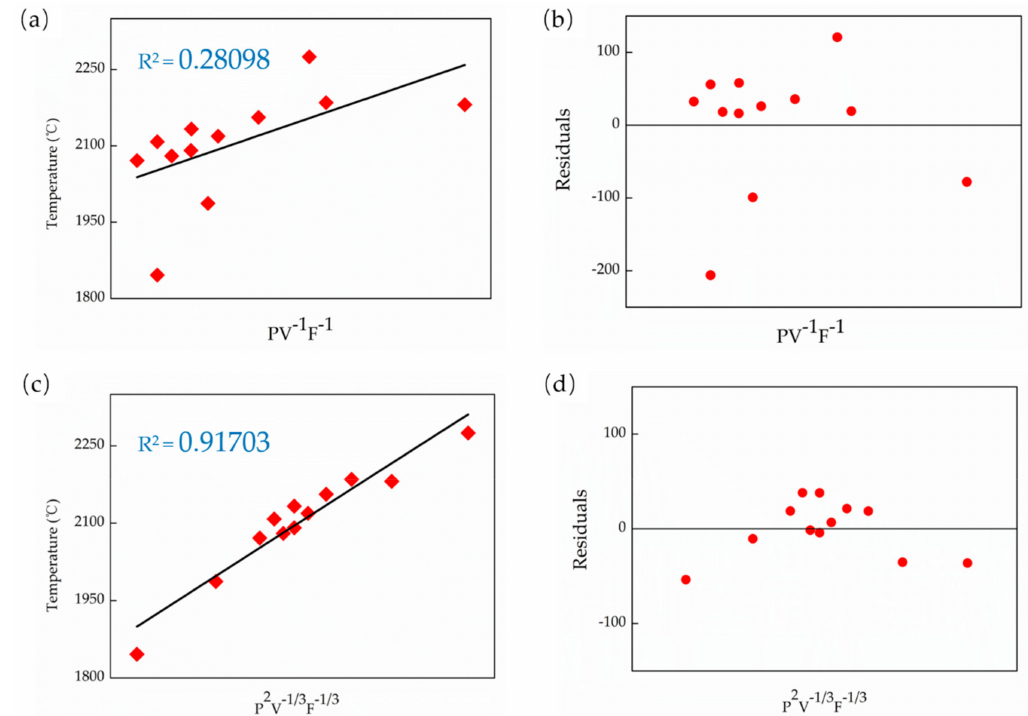
Figure 4. The results of linear regression: ( a ) The temperature versus PV − 1 F − 1 , ( b ) the residuals of PV − 1 F − 1 , ( c ) the temperature versus P 2 V ( − 1 / 3) F ( − 1 / 3) , and ( d ) the residuals of P 2 V ( − 1 / 3) F ( − 1 / 3) .